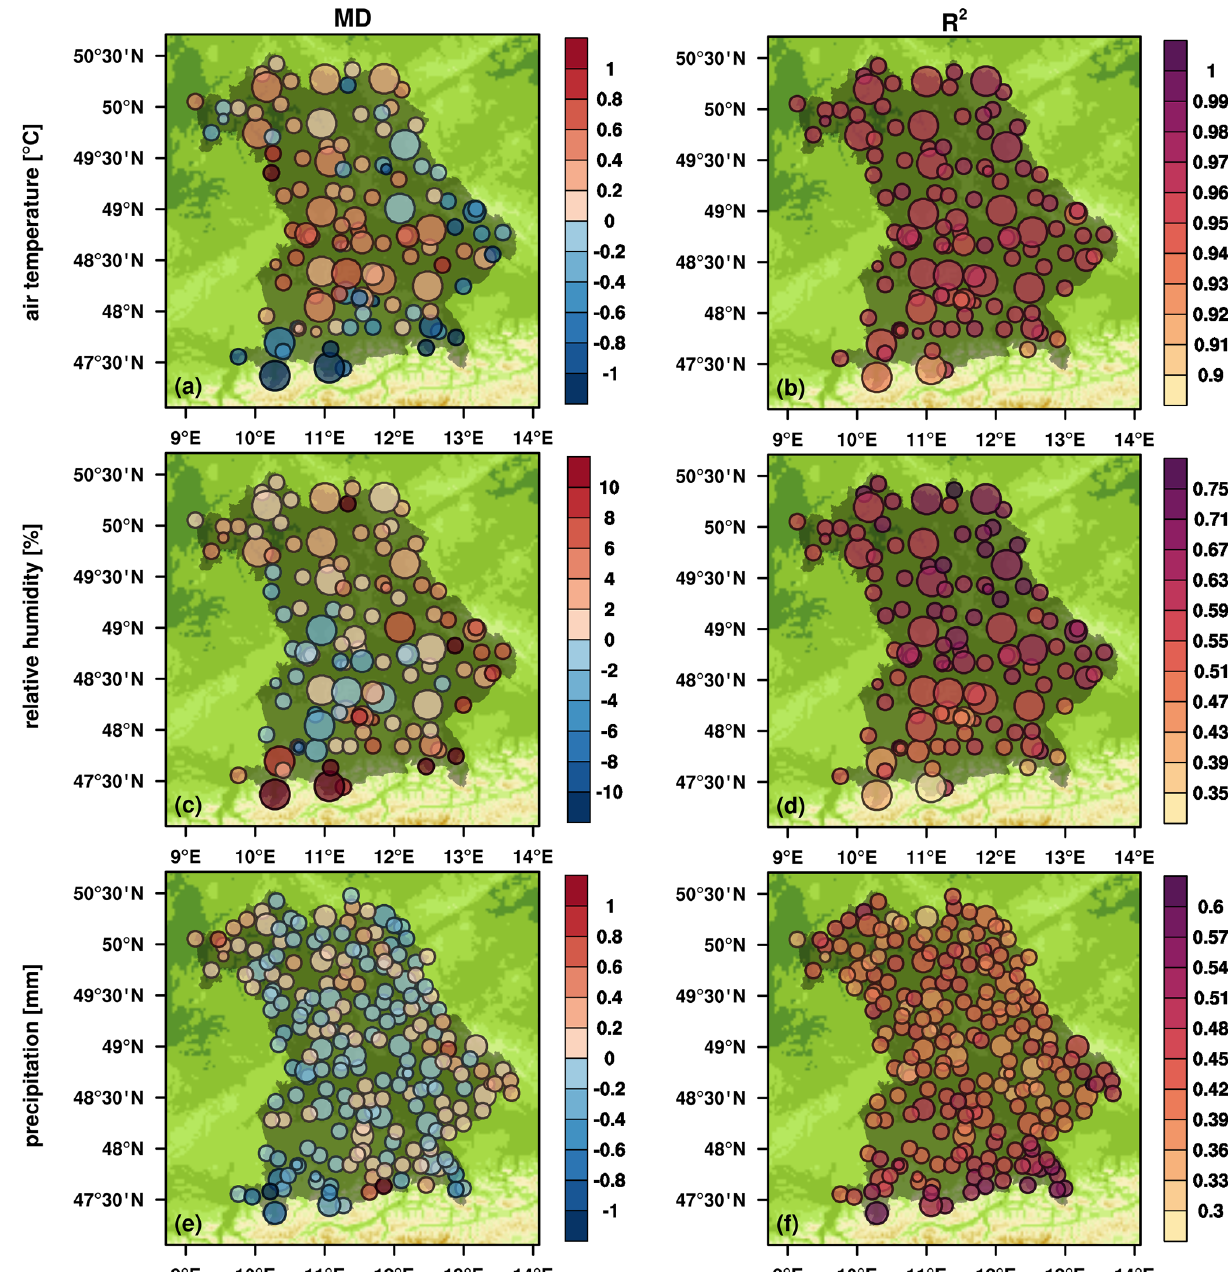
Figure 8. Spatial maps of mean MD (a, c, e) and R 2 (b, d, f) at all stations with valid data between September 1987 and August 2018 for daily mean (a, b) T and (c, d) RH and for daily total (e, f) PR. The four marker sizes group the percentage of the total time steps (11323d) for which data were available at each station into the four quartiles. The largest marker size, which delineates records with more than 75% valid data points, is therefore not available for PR, as this dataset begins on 1 September